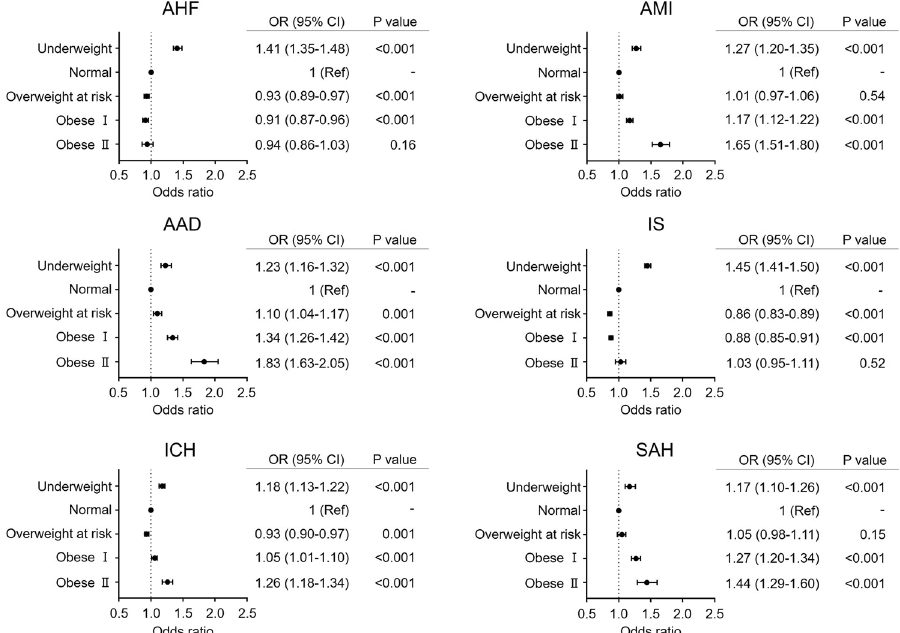
Figure 4. Impact of BMI on in-hospital mortality in each cardiovascular disease (CVD) group: model 2. HT, DM, DL, CKD, CRD, and AF, as well as age and sex, were simultaneously entered into a multivariable logistic regression model to investigate the impact of BMI on in-hospital mortality. Only odds ratios (ORs) and 95% confidence intervals (CIs) of each BMI category are shown. AAD acute aortic dissection, AF atrial fibrillation/ flutter, AHF acute heart failure, AMI acute myocardial infarction, BMI body mass index, CI confidence interval, CKD chronic kidney disease, CRD chronic respiratory disease, DM diabetes mellitus, DL dyslipidemia,